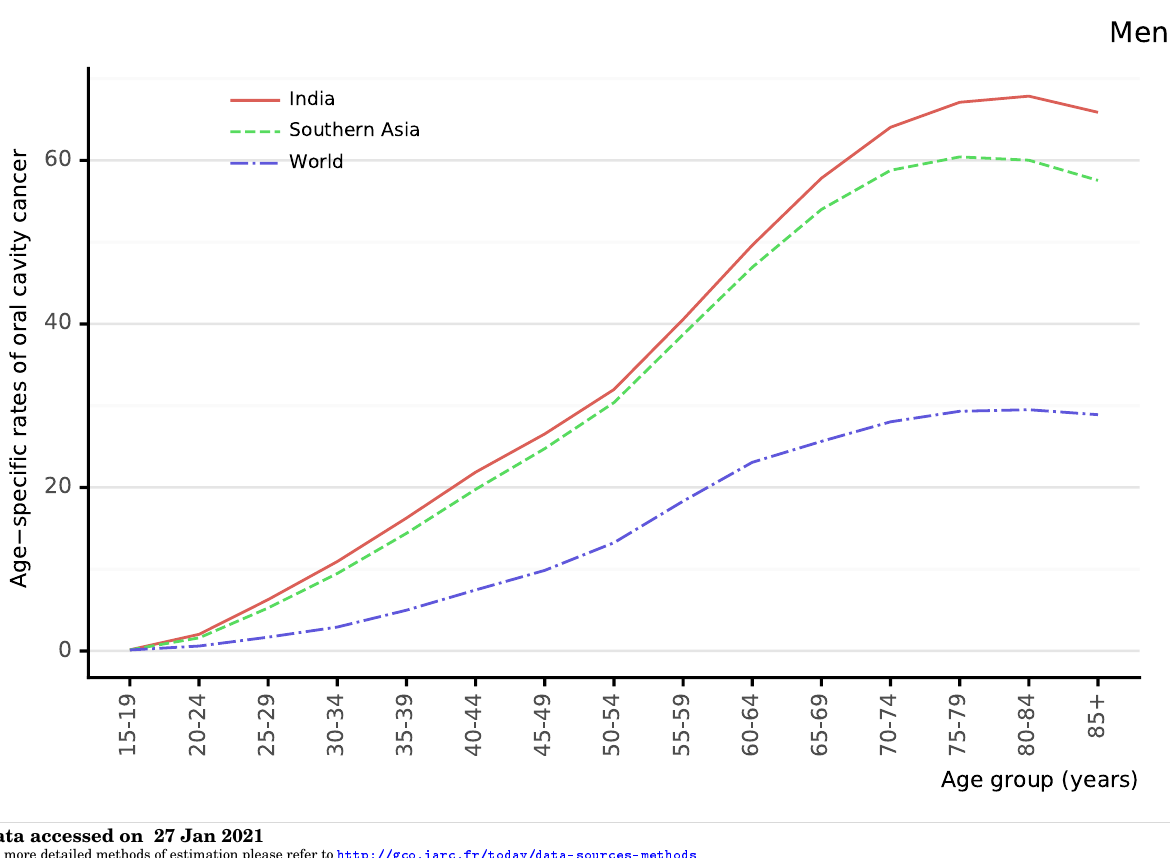
Figure 98: Comparison of age-specific oral cavity cancer incidence rates among men by age in India, within the region, and the rest of